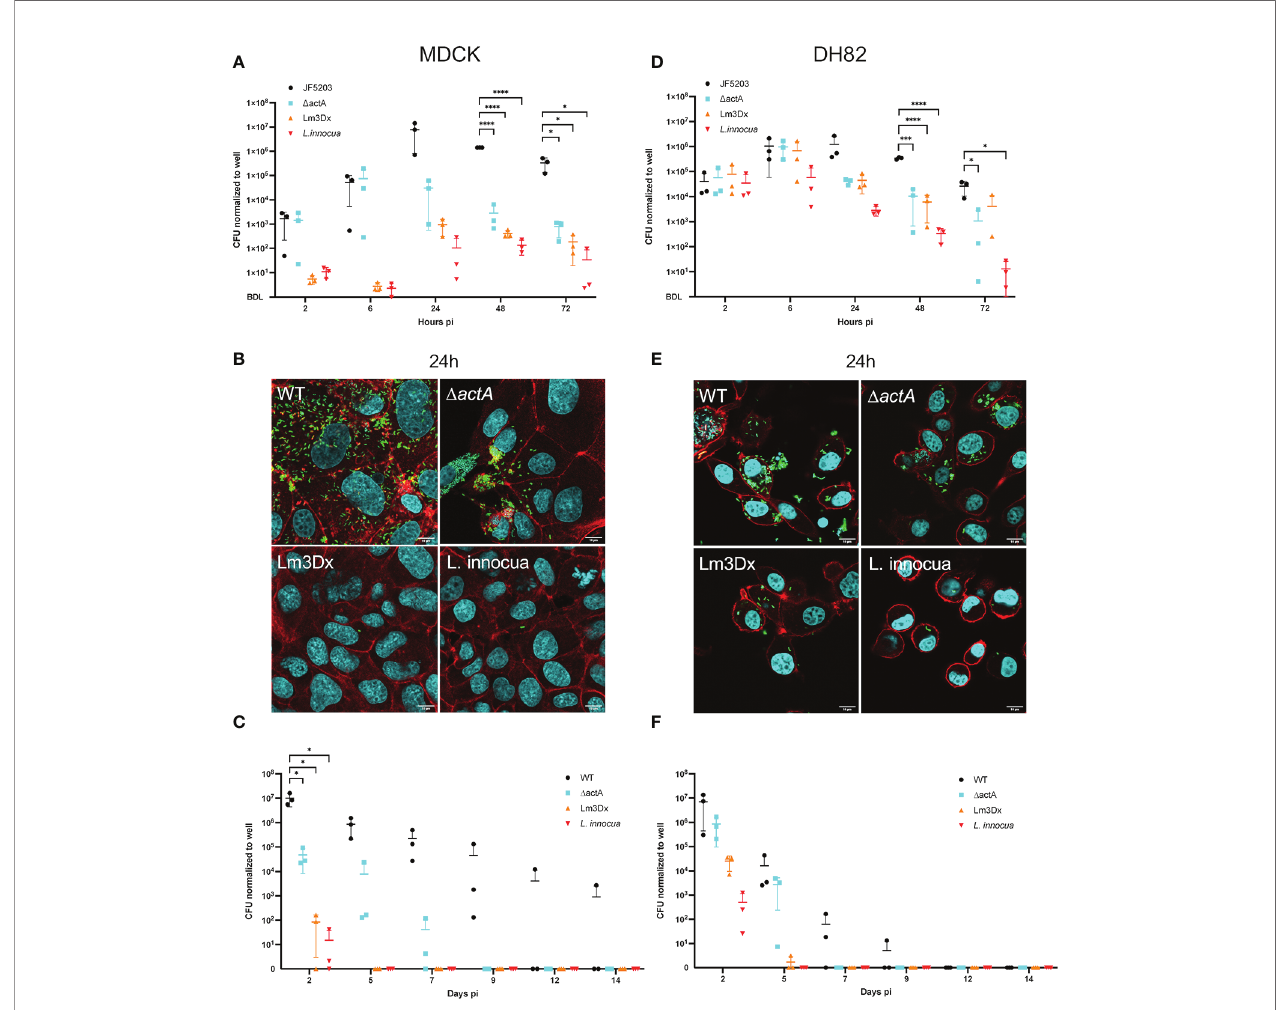
FIGURE 1 | Gentamicin protection assay with the wildtype (WT) parental strain JF5203 (black circles), D actA (blue square), Lm3Dx (orange triangle) and L. innocua (red triangle) in an epithelial (A – C) and macrophage-like cell line (D – F) . For the short-term assay until 72h, canine epithelial cells (MDCK) (A) and canine macrophage- like cells (DH82) (D) were infected for 1h at a multiplicity of infection of 1.25:1. CFU were enumerated at the indicated time points. Immuno fl uorescence microscopy images of MDCK (B) and DH82 (E) at 24h post infection with the parental strain, mutants and L. innocua . Bacteria are shown in green (Listeria-Antibody), cellular actin is stained with fl uorescent phalloidin (red) and cellular and bacterial nuclei with DAPI. At 24h the number of intracellular bacteria is strongly reduced in Lm3Dx- infected MDCK compared to WT-infected and D actA-infected MDCK, and rather similar to L. innocua -infected MDCK (B) . Additionally, Lm3Dx lacks actin polymerization, which is prominent in the WT infected cells (red comet tails). The number of intracellular bacteria is higher in Lm3Dx-infected DH82 cells (D) and the reduction compared to WT is less evident than in MDCK. For the long-term assay until 14d, MDCK (C) and DH82 (F) cells were infected for 1h at a multiplicity of infection of 1.25:1. At the indicated timepoints, cells were detached by trypsin and 50% of cells were transferred to a new well. The remaining cells were lysed and serial dilutions were plated for CFU counting on BHI-Agar. Lm3Dx is cleared more rapidly than the WT from both epithelial and macrophage-like cells. Datapoints in the graphs are from 3 independent experiments performed in triplicate wells and are presented with ± 95% con fi dence interval; *P<0.05, ***P<0.001, ****P<0.0001 (student t test). Because the y-axes of the graphs are in log scale, below detection level (BDL) was added manually to show all values where no CFU were